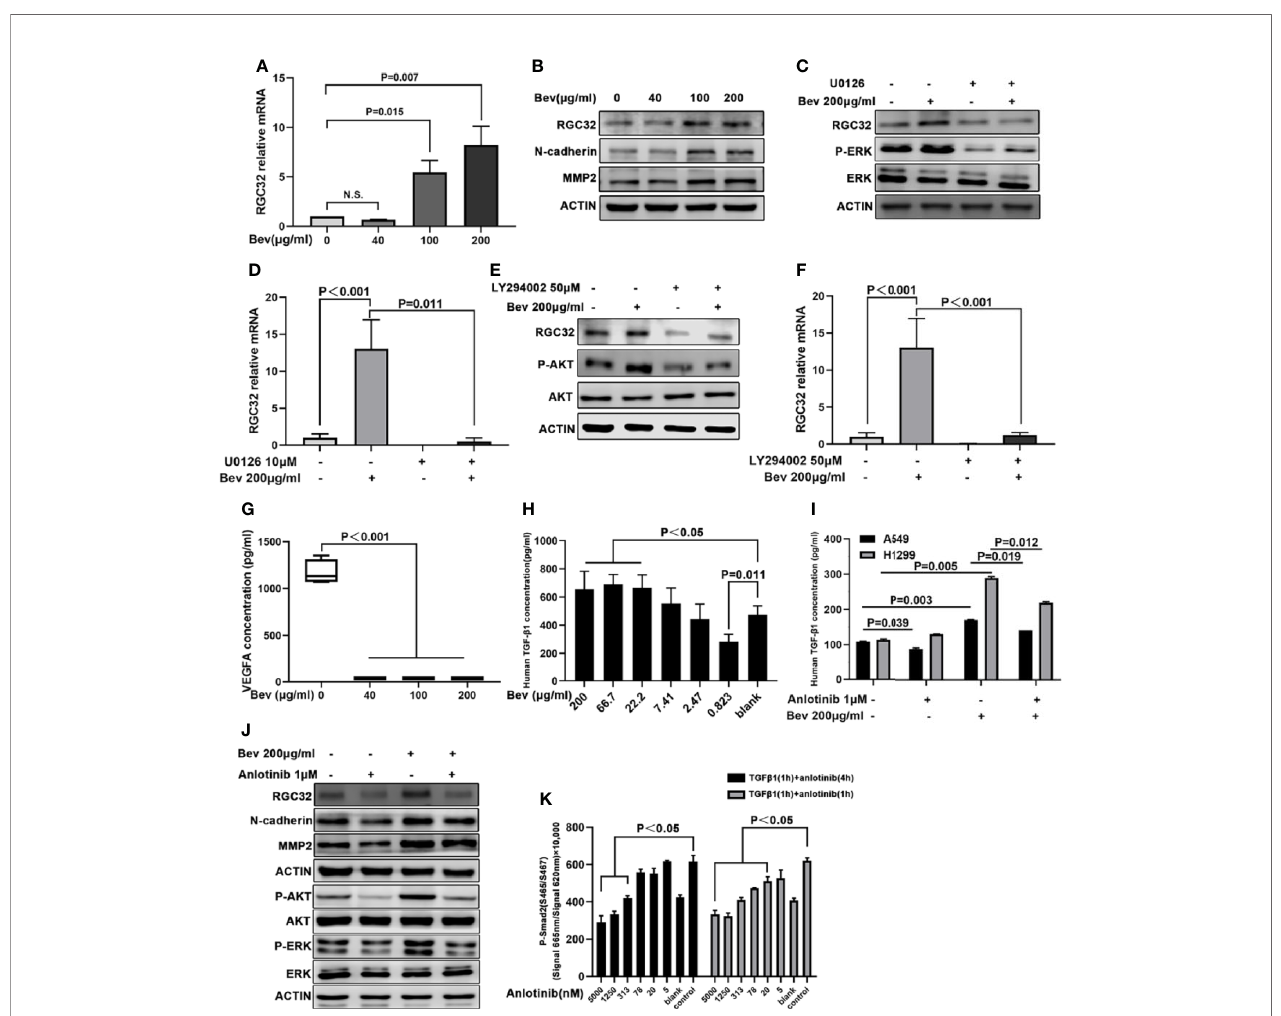
FIGURE 3 | Anlotinib reverses upregulated RGC32 expression by bevacizumab via ERK-MAPK and PI3K-AKT signaling. (A) q-PCR analysis of RGC32 mRNA levels in A549 cells treated with vehicle and bevacizumab at 6-h time point. Values were calculated using the ddCT method. n.s: nonsigni fi cant. (B) Western blot analysis showing RGC32, N-cadherin and MMP2 protein levels in A549 cells after bevacizumab treatment at different concentrations. (C) Western blot analysis of RGC32 and P-ERK protein levels in A549 cells after bevacizumab treatment in the presence or absence of MAPK inhibitor U0126. (D) q-PCR analysis of RGC32 mRNA in A549 cells in response to bevacizumab treatment in the presence or absence of U0126. (E) Western blot analysis of RGC32 and P-AKT protein levels in A459 cells following bevacizumab treatment in the presence or absence of PI3K inhibitor LY294002. (F) q-PCR analysis of RGC32 mRNA in A549 cells in response to bevacizumab treatment in the presence or absence of LY294002. (G) Cultured A549 cells treated with different concentrations of bevacizumab were assessed by ELISA to measure VEGFA. n = 3. (H, I) Cultured A549 cells treated with bevacizumab and anlotinib were assessed by ELISA to measure TGF b . n = 2. (J) Western blot analysis of RGC32, N-cadherin, MMP2, P-AKT, and P-ERK levels in 200 m g/mL bevacizumab and 1 m M anlotinib treated A549 cells. (K) HTRF analysis of P- Smad2 protein levels after anlotinib treatment. n = 2. Bev,